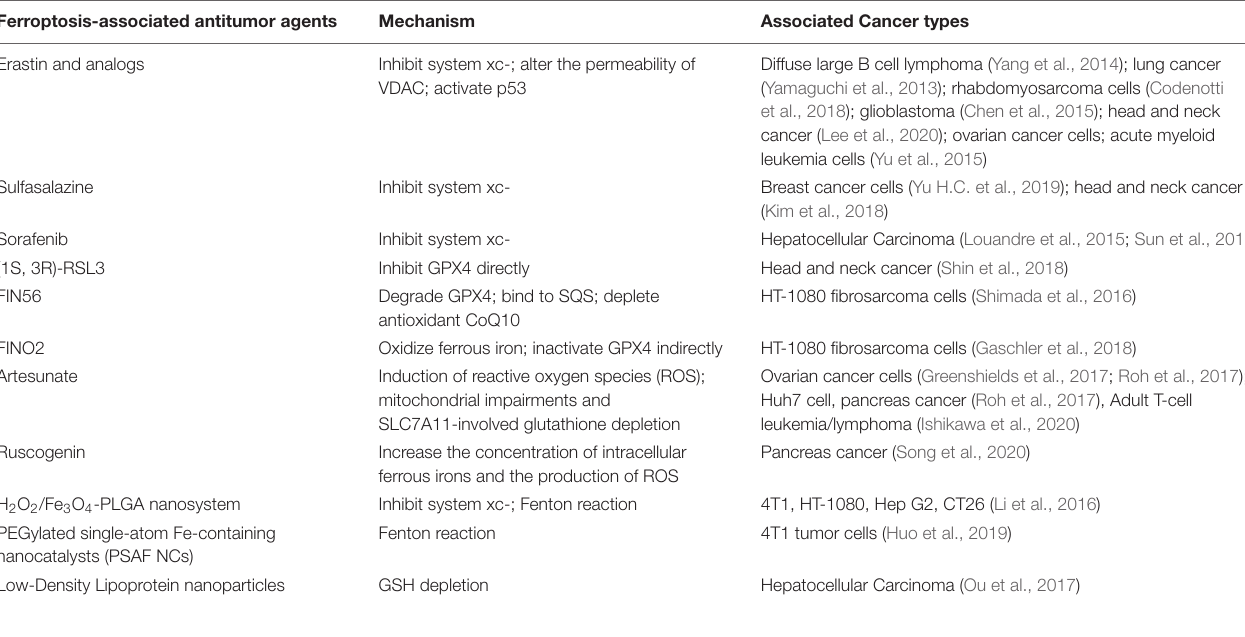
TABLE 2 | Summary of ferroptosis-associated anti-tumor agents. Ferroptosis-associated antitumor